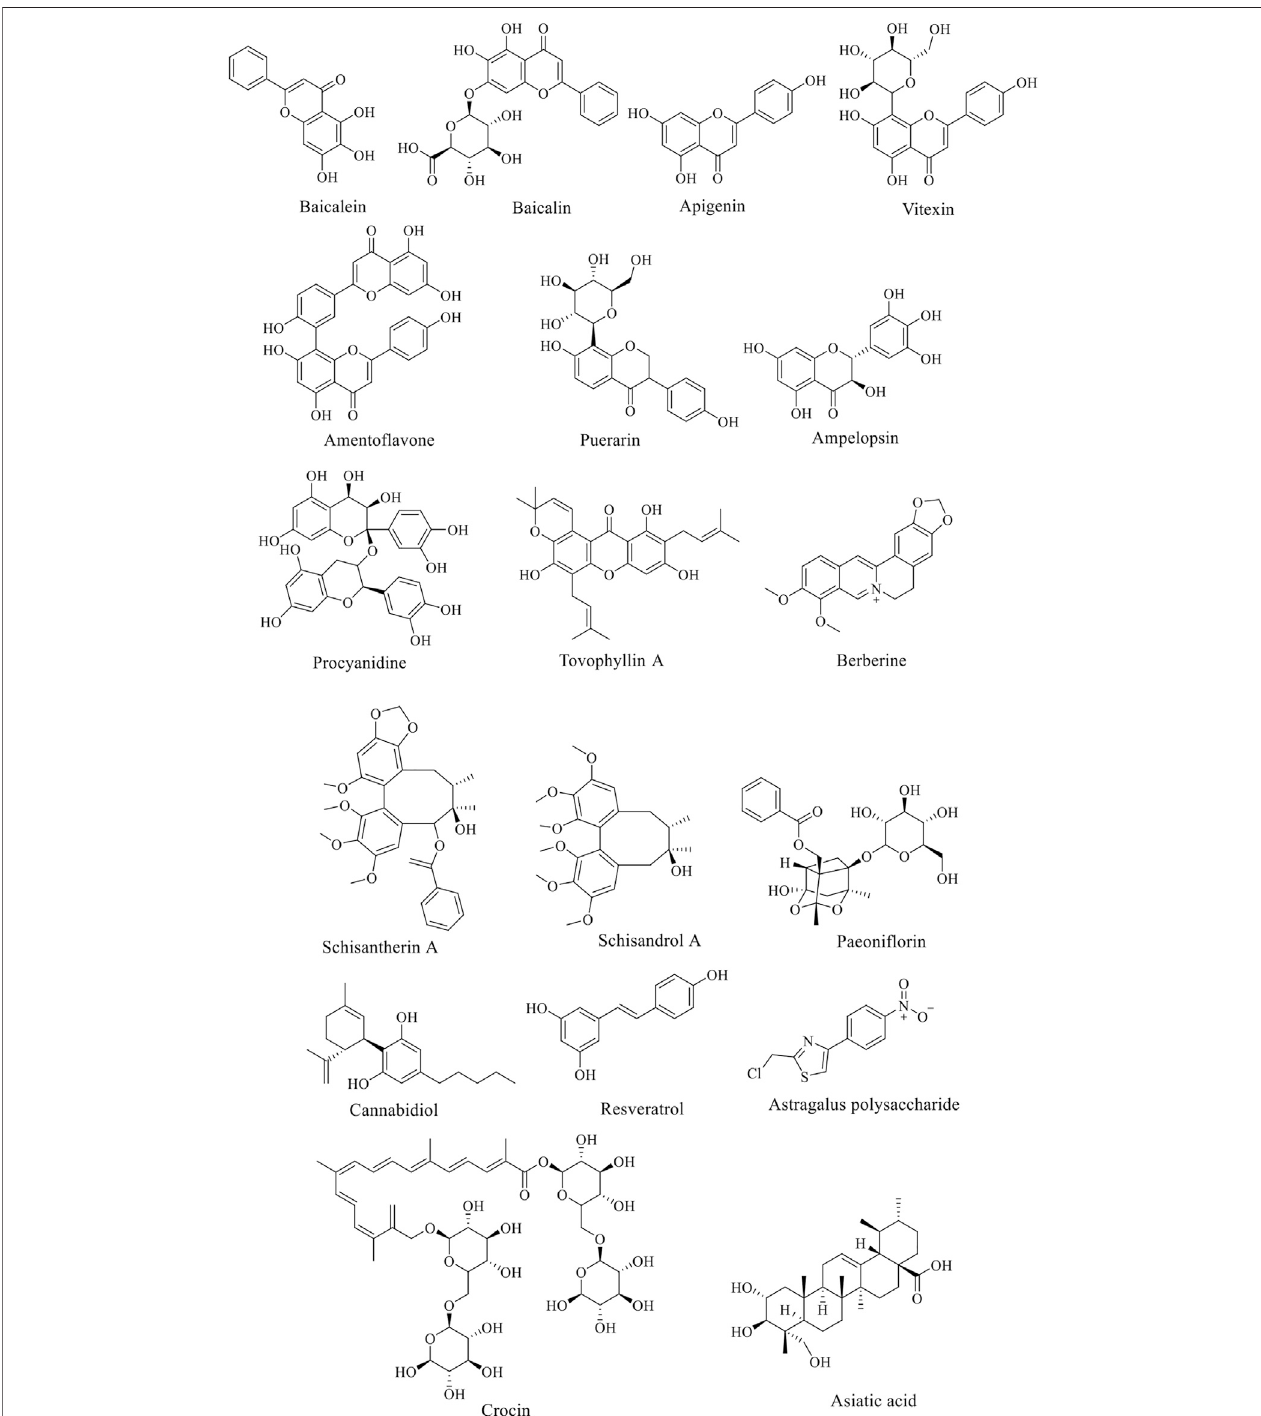
FIGURE 2 | Structure of anti-AD natural